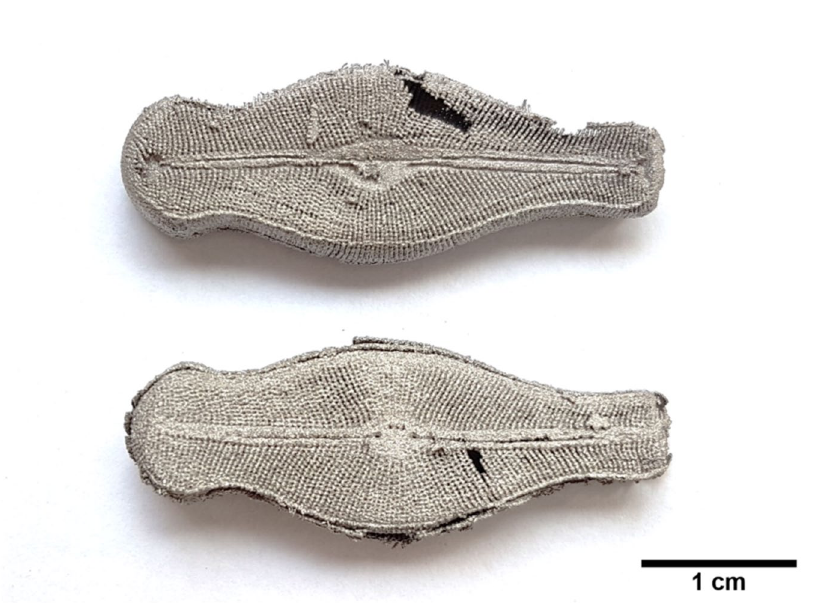
Figure 5. 3D printed engineered object made of titanium, based on the natural diatom frustule